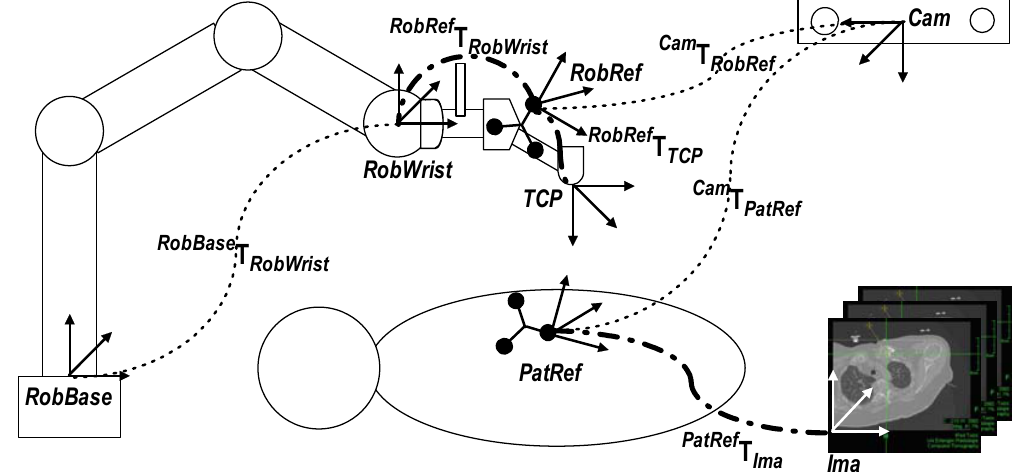
Figure 10. Coordinates and transformations of the system. The dotted lines represent the transformations measured by the navigation system and the robot controller. The dashed lines represent rigid